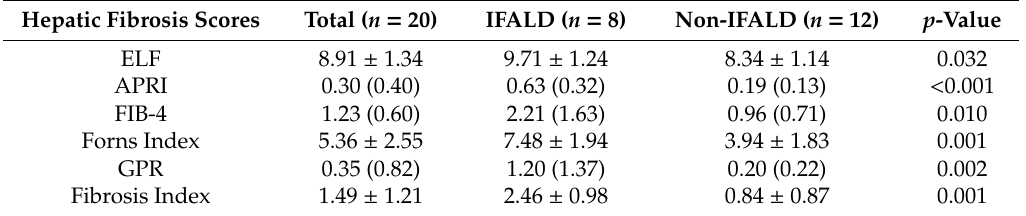
Table 5. Demographic characteristics of patients in the MRI Cohort.